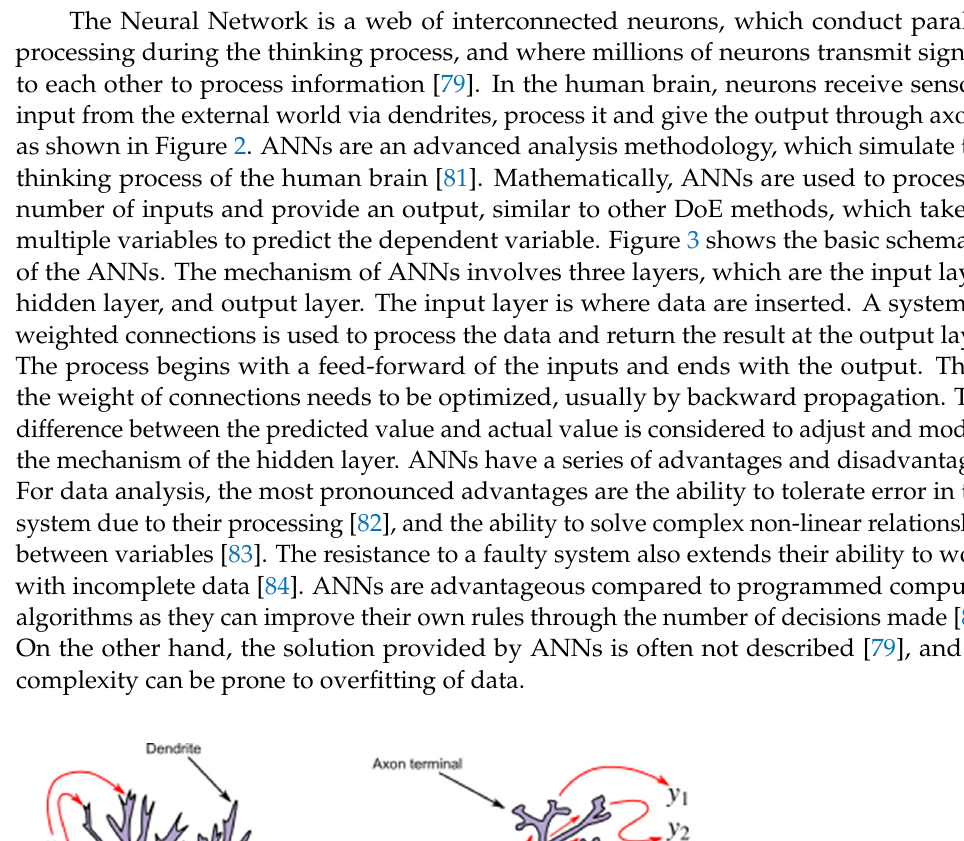
Figure 3. Basic schematic of ANNs [81]. 5.2. The Applications of ANNs Table 9 summarizes the information obtained from the reviews of ANNs-related literature. As observed, a variety of tools and software are used by researchers to conduct ANNs. MATLAB, with the Neural Network Fitting Tool [86], remains a popular choice that has been used in many studies [38,87,88]. Other than that, several researchers used other software such as JMP [74], QBasic [89], Neuro Solutions [90], and WEKA [91]. Unlike other DoE methods reviewed, ANNs are a more complex system which requires various setup steps. First, the perceptron needs to be constructed by setting up the number of input nodes, hidden layer, and hidden nodes. The number of input nodes is simply the number of variables in the studies. However, there is no requirement for a fixed number